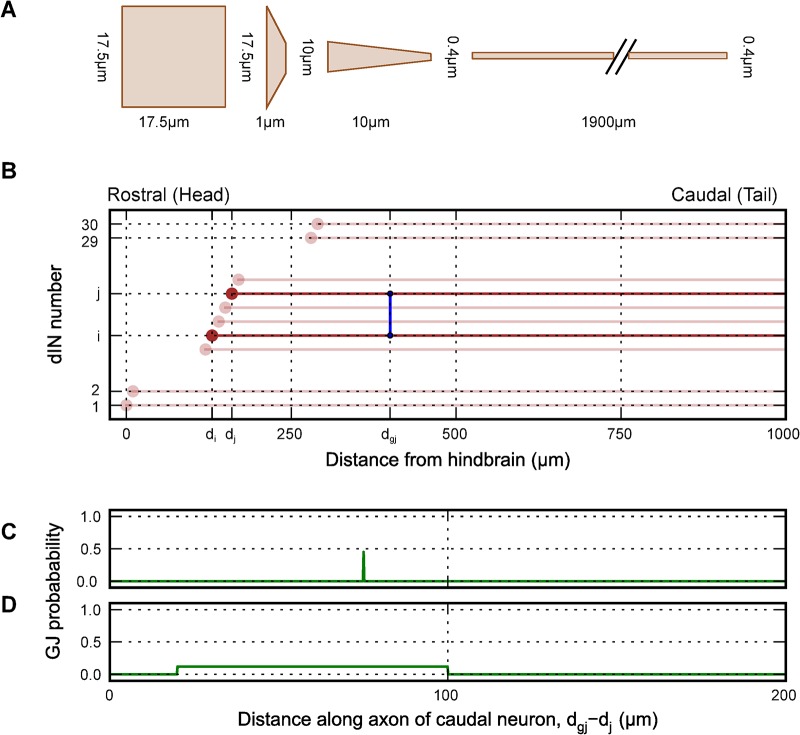
A passive population model of descending interneurons in the hindbrain and rostral spinal cord and their gap junctions.(A) dIN morphology was approximated as four sections each modelled as a cylinder or tapered cylinder, one for the soma, two for the hillock and one for the axon (not to scale). (B) The somata of the dINs form a rostral-caudal column (light: circles = somata) each with a descending axon (lines). In this example, there is a single gap junction (dark vertical line) between a pair of dINs {i, j}. (C, D) Two layout schemes for generating gap junctions between two axons were tried, to evaluate their effects on coupling coefficients: (C) A gap junction could occur with a certain probability at a fixed point along the axon of the more caudal dIN; (D) A gap junction could occur with a certain probability at any location within a defined region of the axon of the more caudal dIN.